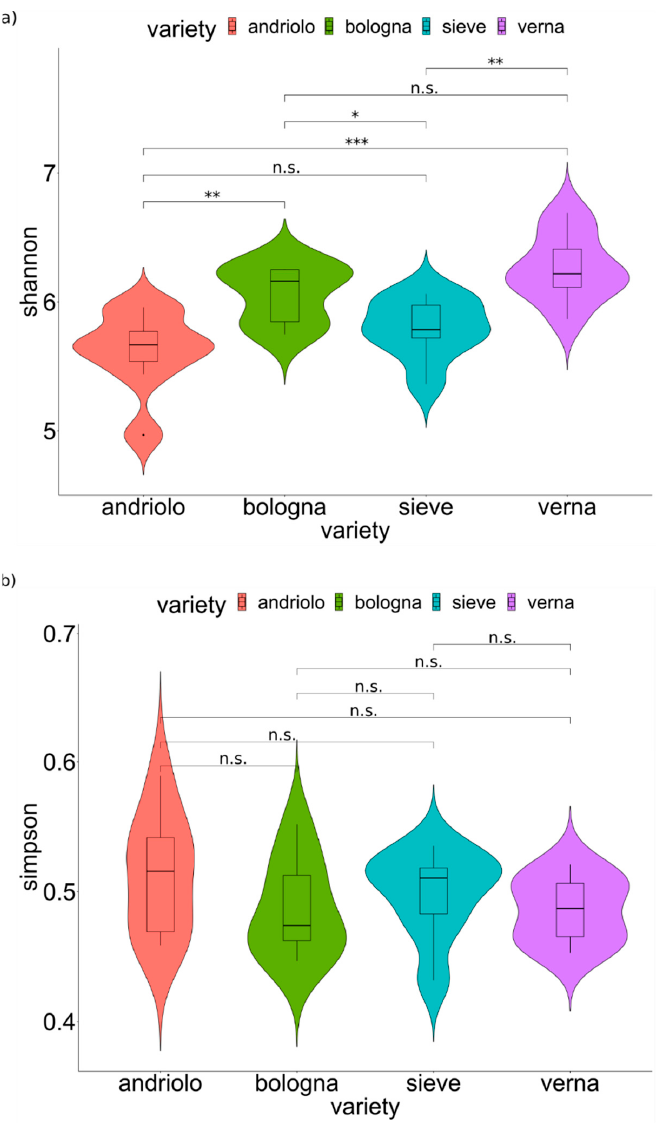
Figure 2. Diversity of soil and rhizosphere bacterial community. Values for alpha diversity indices are reported. Violin plots with samples (bulk and rhizosphere soil) are grouped according to varieties. Statistical analyses were performed using the Wilcoxon test ( p -values are reported over the lines: *, p < 0.05; **, p < 0.01; ***, p < 0.001; n.s., not significant p > 0.05). The y axis indicates the values of the Shannon index ( a ) and the values of the Simpson index ( b ).